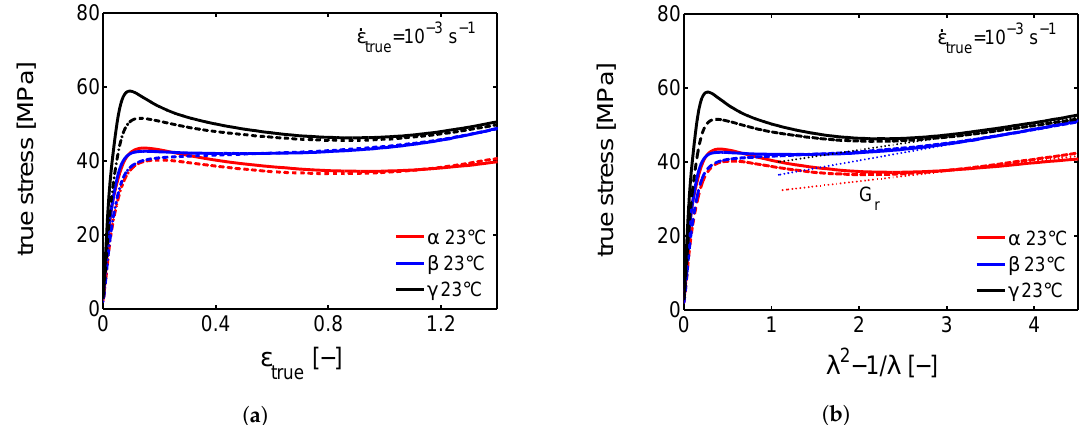
Figure 9. ( a ) True stress-true strain curves for α -, β - and γ -iPP. The results are obtained from uni-axial compression experiments at a strain rate of 10 − 3 s − 1 and a temperature of 23 ◦ C on samples with a dimension of Ø6 × 6 mm 2 ( β - and γ -iPP) or Ø3 × 3 mm 2 ( α -iPP). The dashed lines are the true stress-true strain response obtained on thermally rejuvenated samples; ( b ) The corresponding Gaussian plots for α -, β - and γ -iPP. The dotted lines represent the strain hardening moduli G r